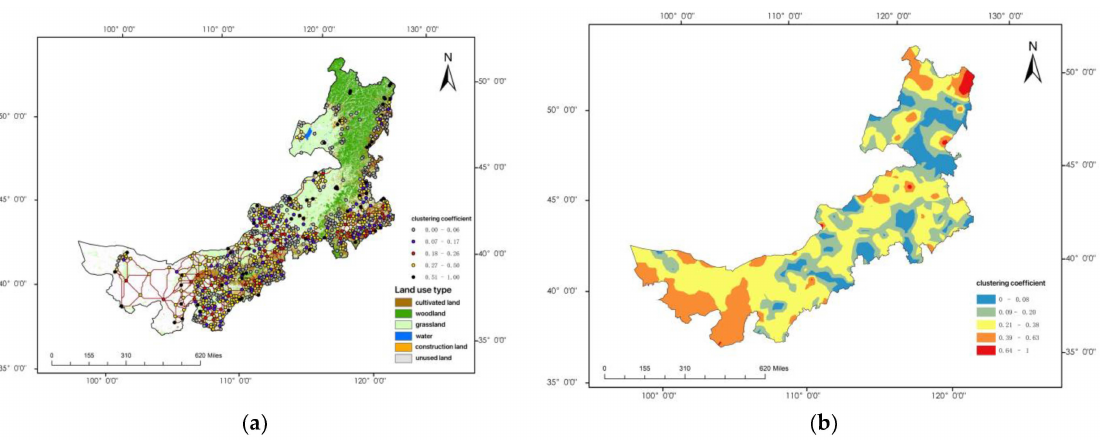
Figure 10. ( a ) Spatial distribution of node clustering coefficient; ( b ) spatial distribution prediction. The clustering coefficient-degree correlation indicates the relationship between the clustering coefficient and the degree of the node in the ecospatial network. In order to get a more distinct rule between the two, this paper performed logarithmic processing